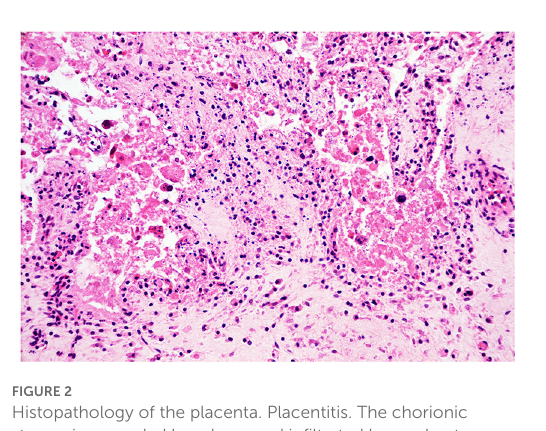
FIGURE1 Histopathology of the tongue. Glossal myositis. The interstitium separating the myocytes is infiltrated by moderate numbers of inflammatory cells, notably lymphocytes and histiocytes. H&E stain, original magnification 400x.